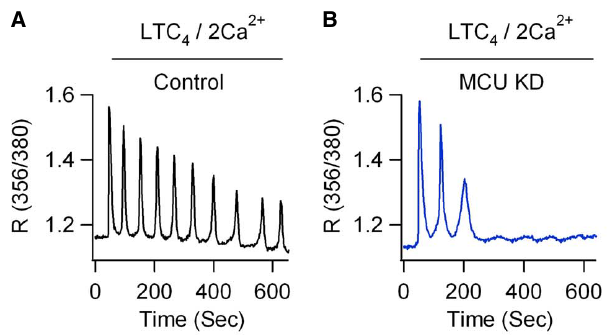
Figure 3. The mitochondrial Ca 2+ uniporter (MCU) participates in the fine tuning of Ca 2+ oscillations. A. Control recording of Ca 2+ responses in rat basophilic leukemia (RBL)-1 cells stimulated by LTC4 in 2 mM external Ca 2+ . B. Same recording after MCU knockdown. Ca 2+ entry in mitochondria via the MCU broadens cytosolic Ca 2+ spikes and decreases their sustainability.